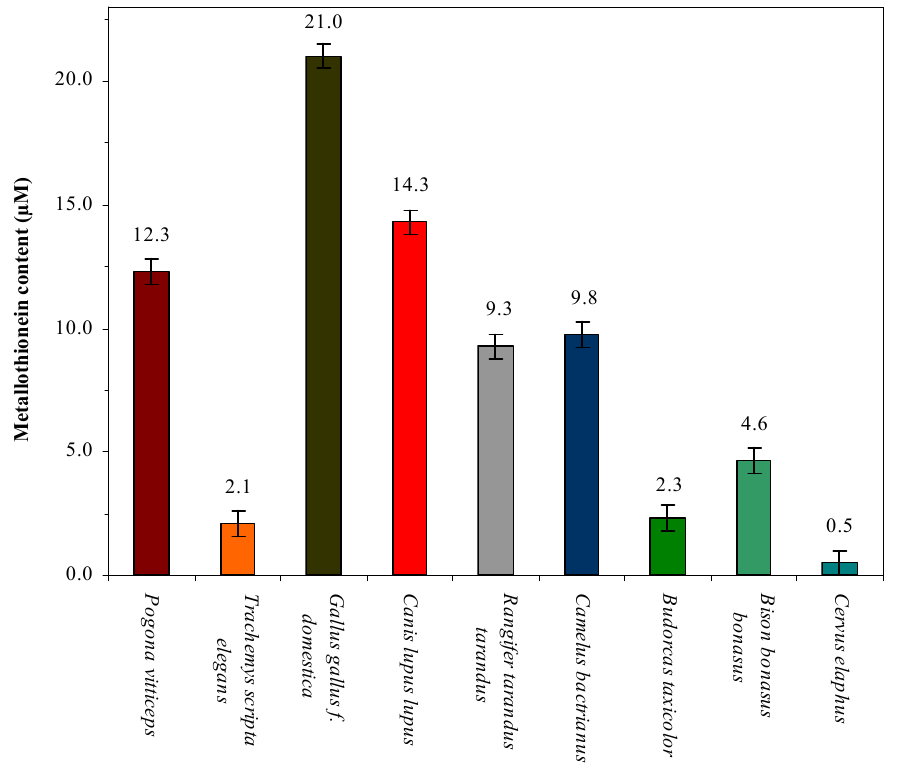
Animal Figure 4. Metallothionein levels in individual animal species evaluated using a calibration curve.